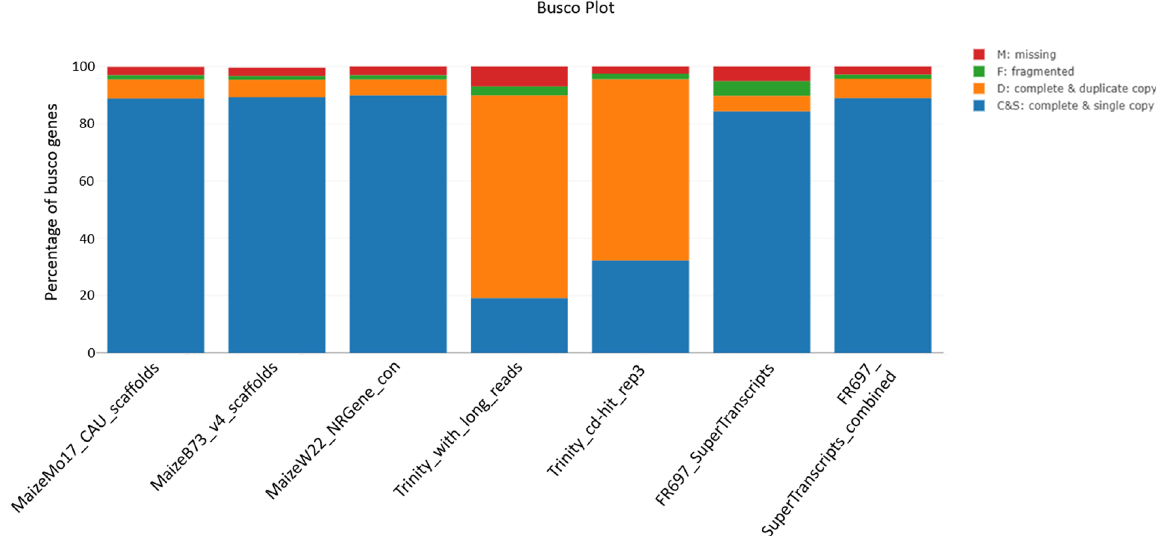
Figure 8. BUSCO analysis of “FR697 combined SuperTranscriptome” (full maize gene sequences replacing their annotated SuperTranscriptome counterparts) compared against the unmodified